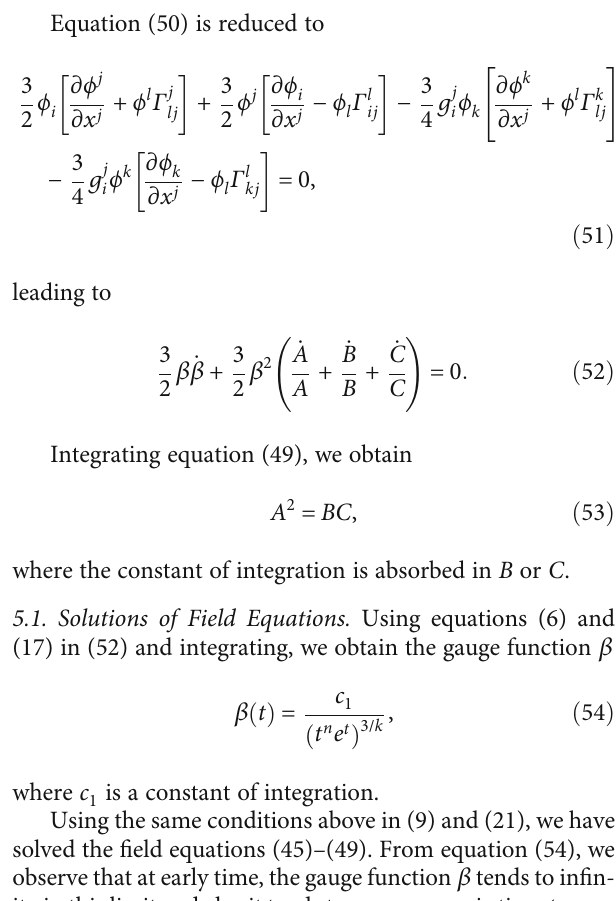
= 1 Figure 7: The plot of gauge function β ð t Þ versus cosmic time t for n = 1 : 5 , 2, and 2.5 and k = 0 : 5